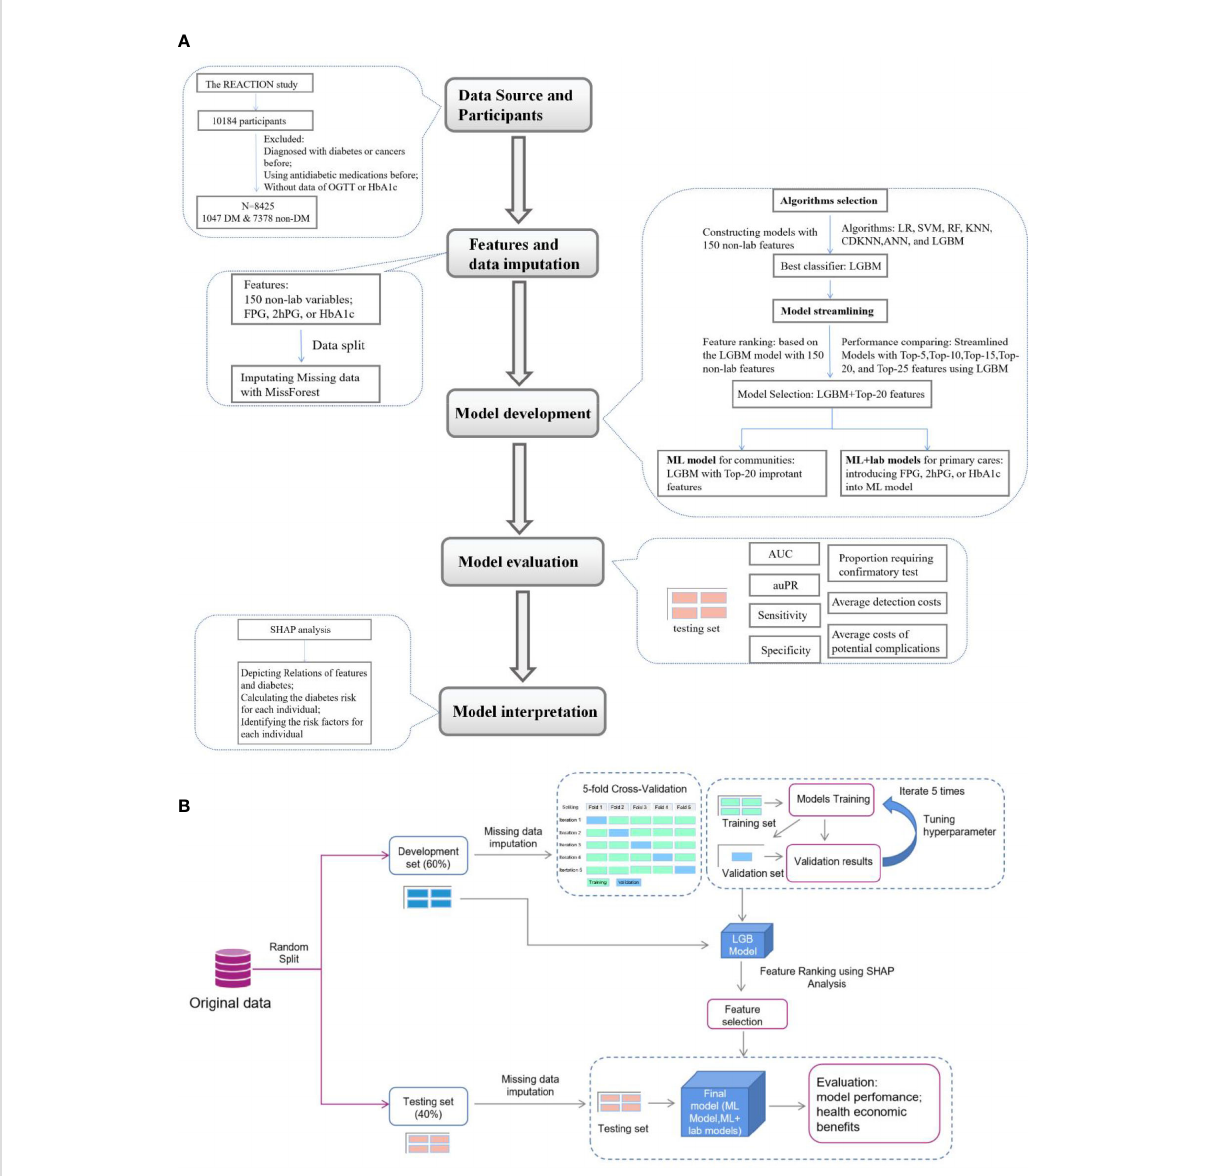
FIGURE 1 Flow diagram of the research. (A) , Overview of the study. (B) , Details of feature selection and model evaluation REACTION, Risk Evaluation of Cancers in Chinese diabetic Individuals; N, the numbers of participants involved in this study; DM, person with diabetes mellitus; SHAP analysis, Shapley Addictive exPlanations analysis; LR, Logistic Regression; SVM, Support Vector Machine; RF, Random Forest; KNN, K-nearest neighbors algorithm; CDKNN, Centroid-Displacement-based-k-NN; ANN, Arti fi cial Neuron Network; LGBM, light gradient boosting machine; AUC, area under the receiver operating characteristic curve (ROC); auPR, area under the precision versus recall